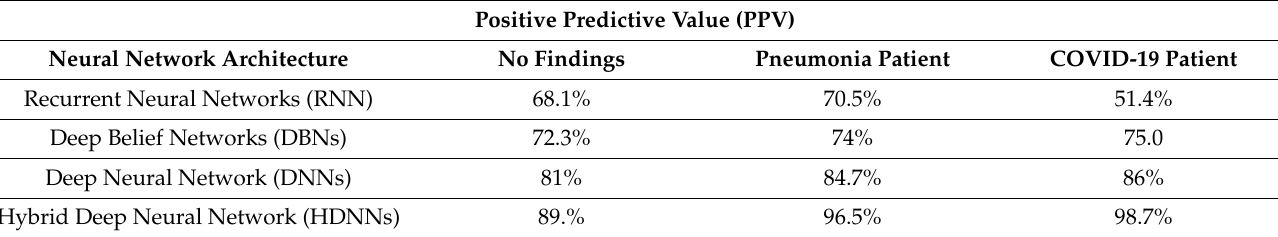
Table 3. Positive predictive value (PPV) for each infection